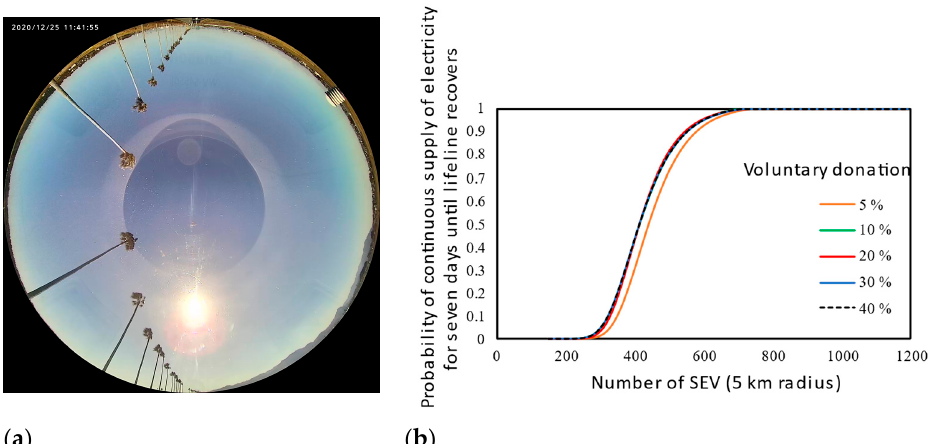
Figure 16. Probability of sustaining resilience energy for a week in open zone: ( a ) fisheye image; ( b ) probability curves.